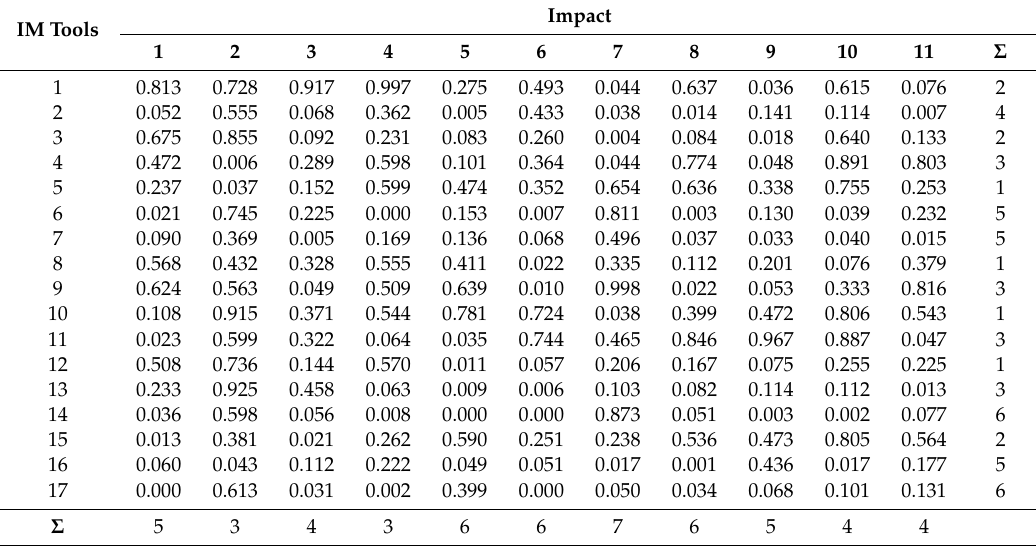
Table 3. Resulting p -values of the correlate analysis test of the pair tool × impact. IM